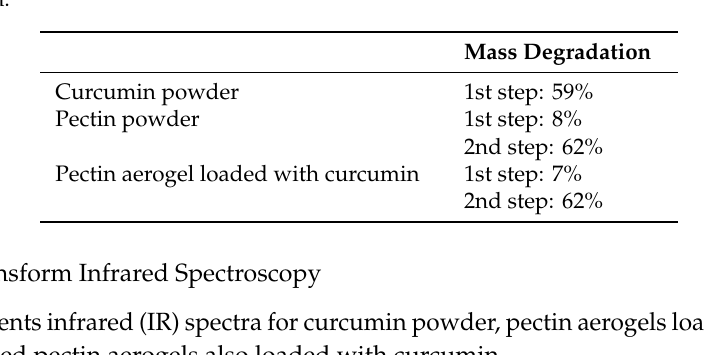
Table 2. Mass degradation of curcumin powder, pectin powder, and pectin aerogel loaded with curcumin.